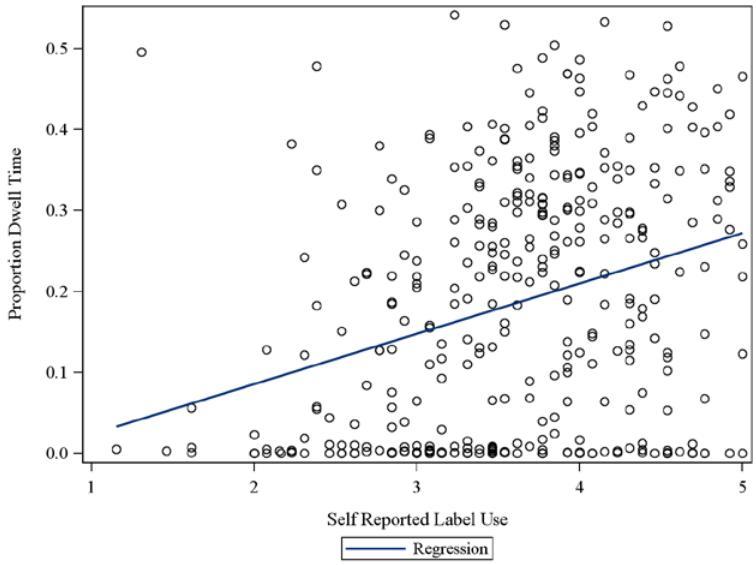
Figure 2. Objective Food Label Use (proportion dwell time) by Self-Reported Food Label Use.